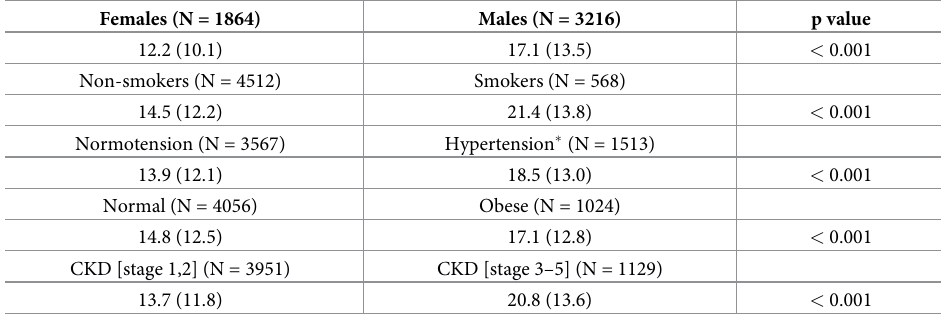
Table 3. Qrisk3-score (%) per group separated for sex and major atherosclerotic cardiovascular risk factors, Mean (SD).